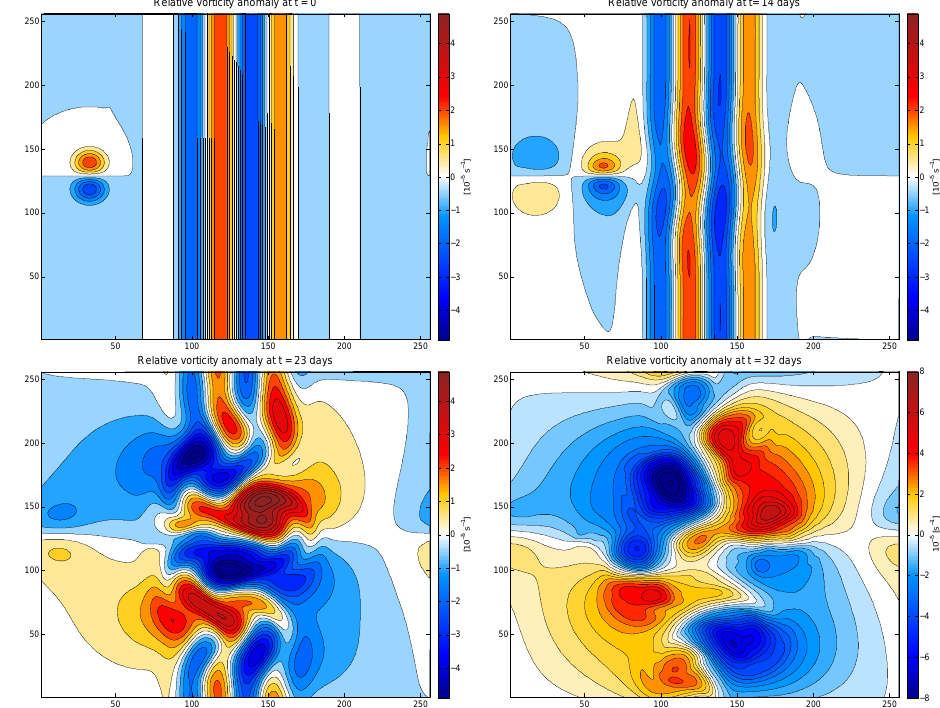
Figure 14. Evolution of the relative vorticity of a Rossby wave interacting with a dipolar